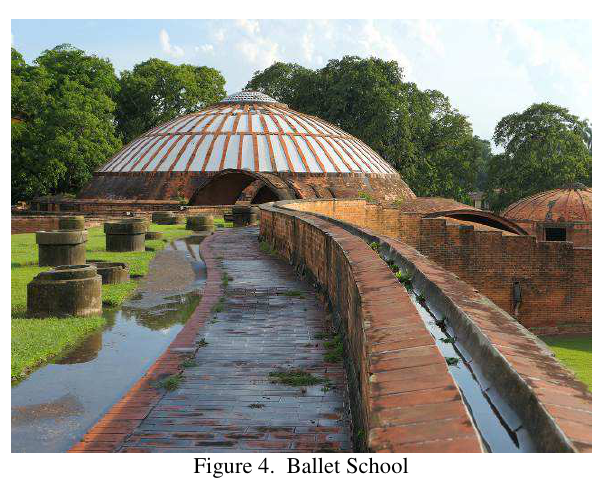
Figure 3. Ballet School